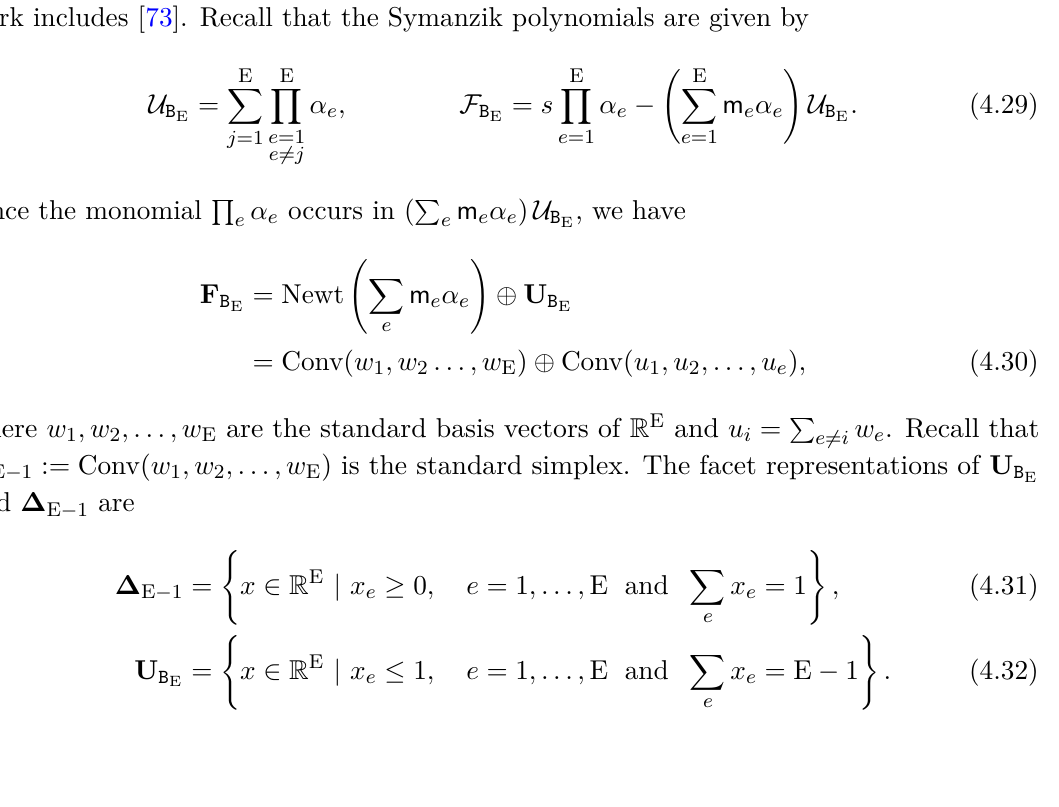
Figure 5. From left to right: polytopes U to the corresponding subdiagram γ ⊂ par